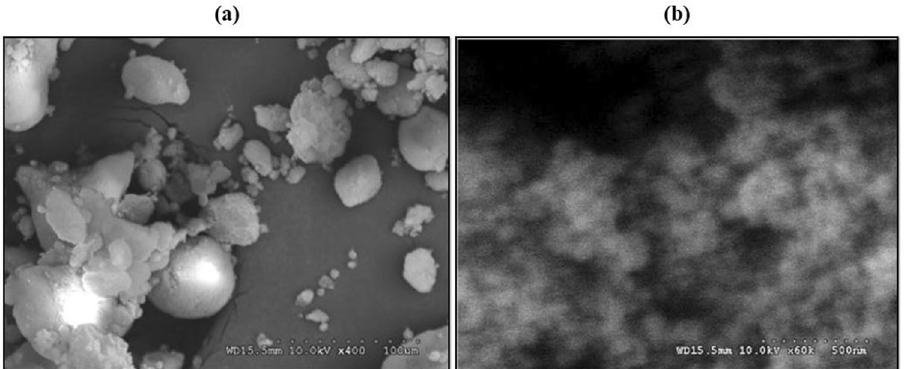
Fig. 11 SEM micrographs of silica nanoparticles [59]: a : agglomeration of nano-silica particles; b : high magnification of silica